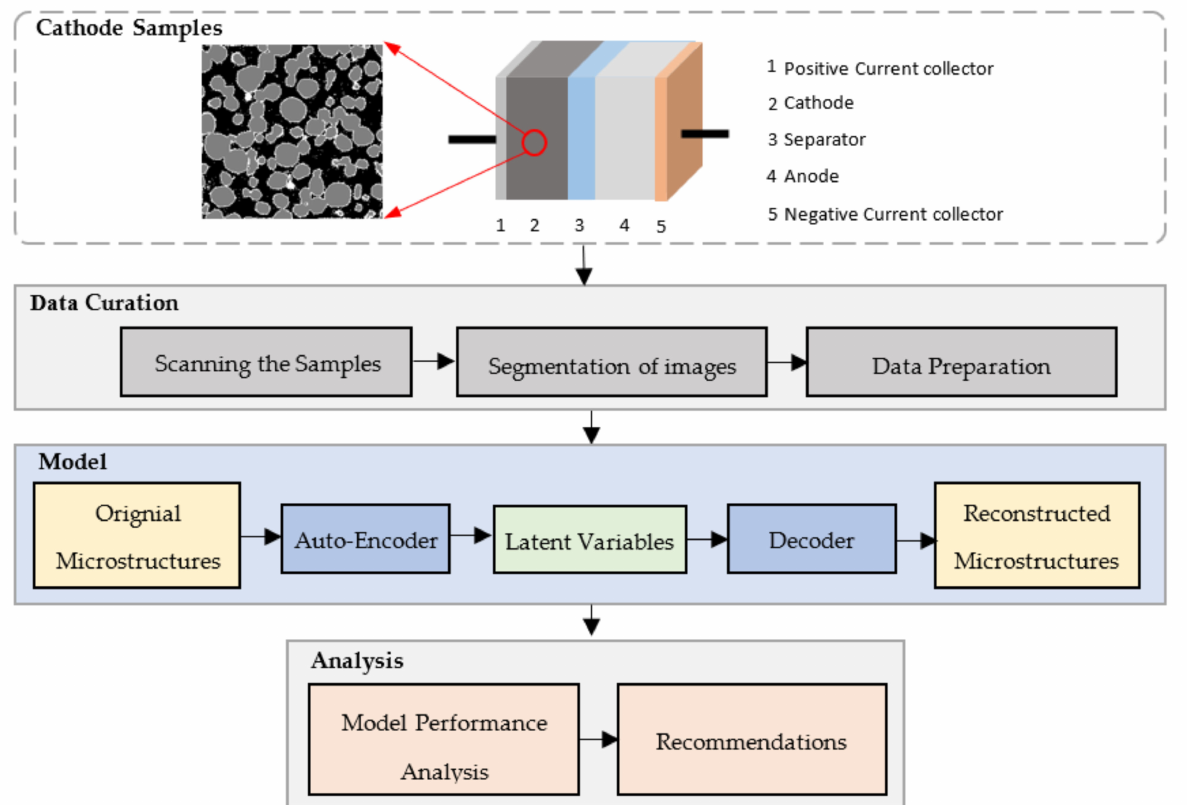
Figure 1. The flowchart of the proposed methodology including the structure diagram of lithium- ion